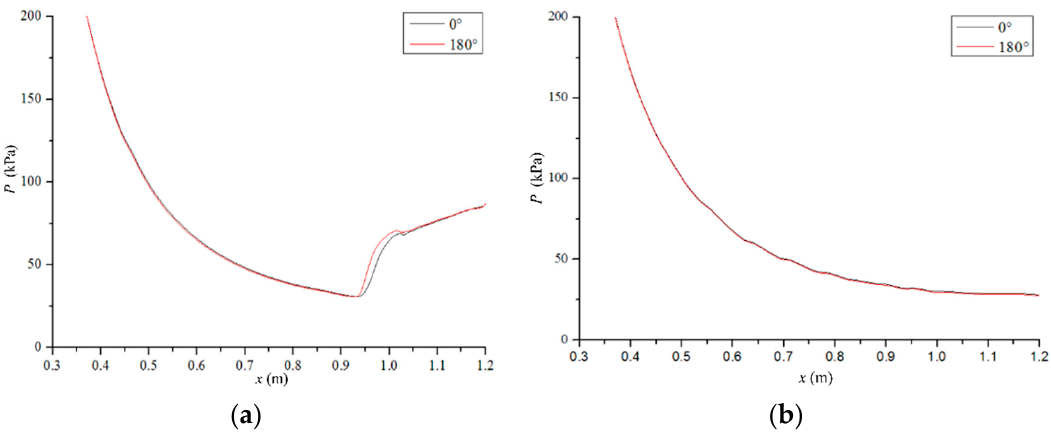
Figure 20. Pc = 6 MPa. The wall pressure distribution. ( a ) Ground. ( b ) High altitude. The results in Figure 20 show that under the conditions of ground separation, the wall pressure distribution curves of the intersecting lines at different angles do not completely overlap. Before reaching the minimum pressure, the curves of the intersecting lines at different angles overlap well; after the minimum pressure, the curves begin to deviate,